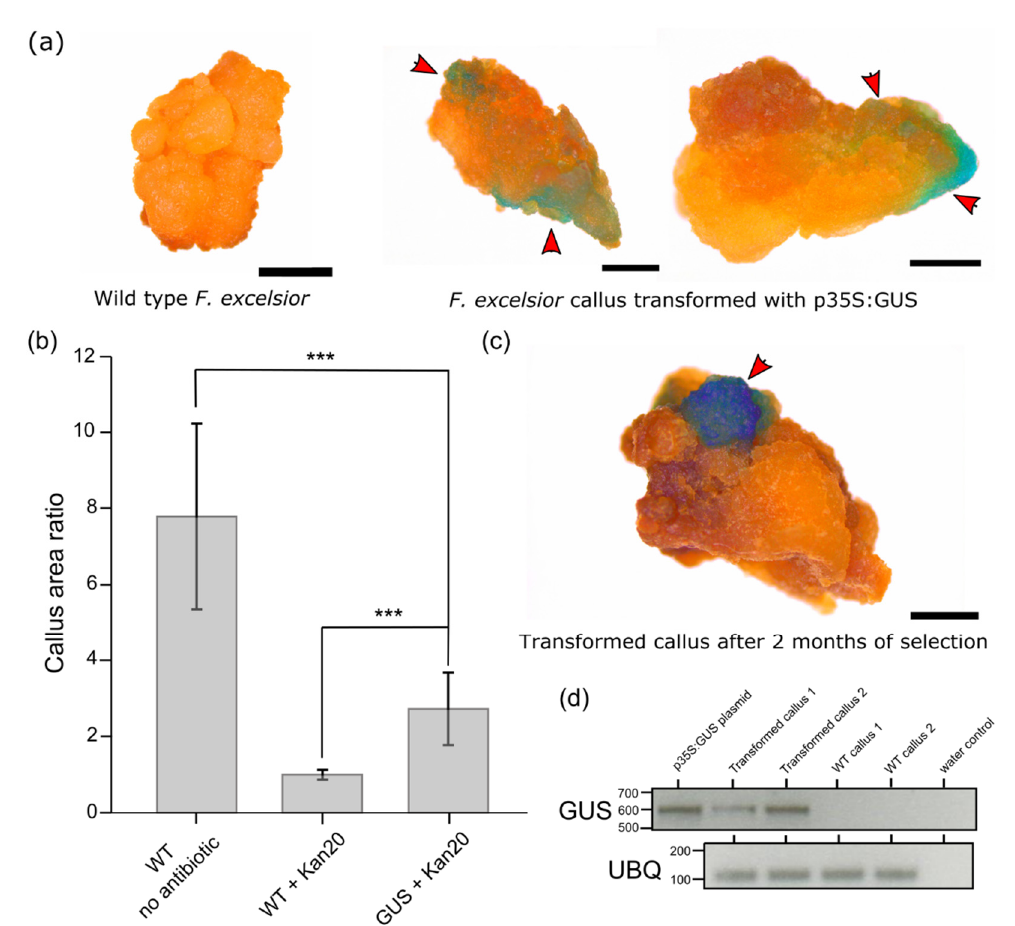
Figure 2. Transformation of F. excelsior callus. ( a ) Control (left) and transformed (right) callus fragments stained for GUS activity 10 days after incubation with AGL-1 A. tumefaciens . ( b ) Comparison of area increases for WT callus grown on medium without (WT no antibiotic) and with 20 µ g/mL kanamycin (WT + Kan20) and for callus transformed with the pORE-R1:prom35S:GUS construct (GUS + Kan20). ( c ) Transformed callus fragment stained for GUS activity eight weeks after incubation with AGL-1 A. tumefaciens . ( d ) RT-PCR results for GUS (top) and UBIQUITIN (UBQ, bottom) amplified for two transformed and WT calli lines. For GUS, a purified pORE-R1:prom35S:GUS was used as a template in a positive control reaction. Water was used as a template in negative control reactions. Size bars in ( a ) and ( c ) correspond to 1 mm, red arrows indicate zones with GUS activity. The Student’s t -test was used to analyse the statistical significance in ( b ), *** denotes p ≤